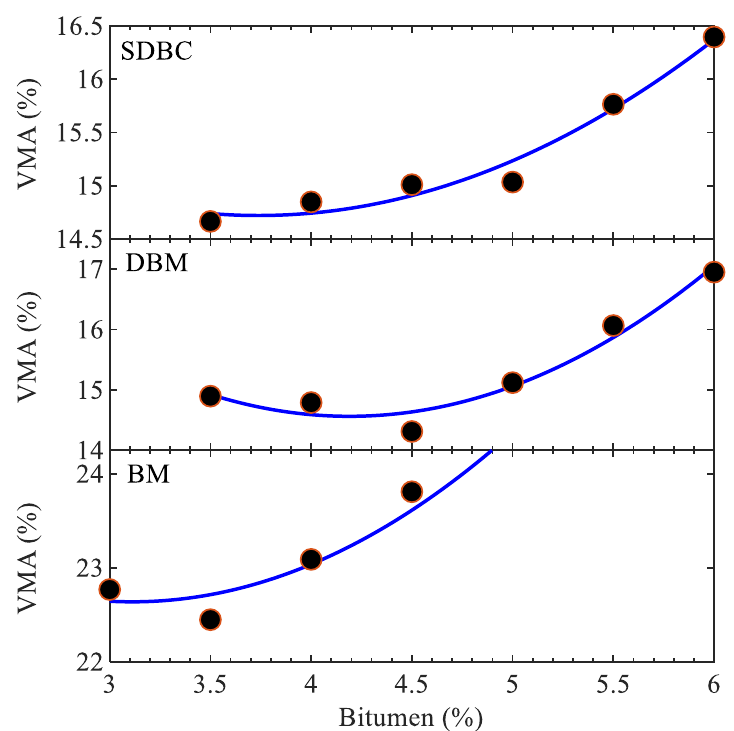
Fig. 11 Relations between voids in mineral aggregates with bitumen content for SDBC, DBM, and